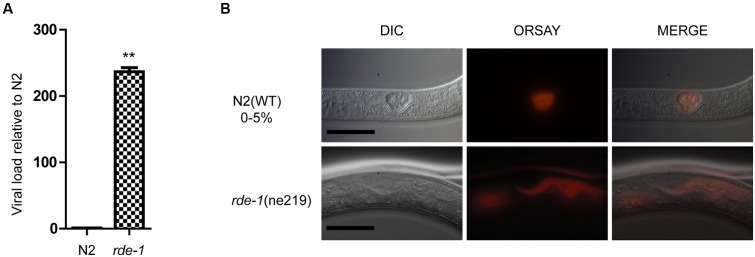
Validation of Orsay virus replications in N2 and rde-1 (ne219) mutant. (A) qRT-PCR analysis of viral loads after 4 days Orsay virus infection in N2 and rde-1 (ne219). rde-1 (ne219) mutant animals showed significantly higher levels of Orsay virus RNA compared to N2 animals do (P < 0.01, t-test). (B) Fluorescence in situ hybridization (FISH) staining of Orsay viral RNA1 in Caenorhabditis elegans N2 and rde-1 (ne219) mutant. Viral RNA1 were detected using Quasar® 670 labeled RNA FISH Probe corresponding to the RNA1 of Orsay virus. Red indicates the Orsay viral RNA and all scale bars represent 20 μm.